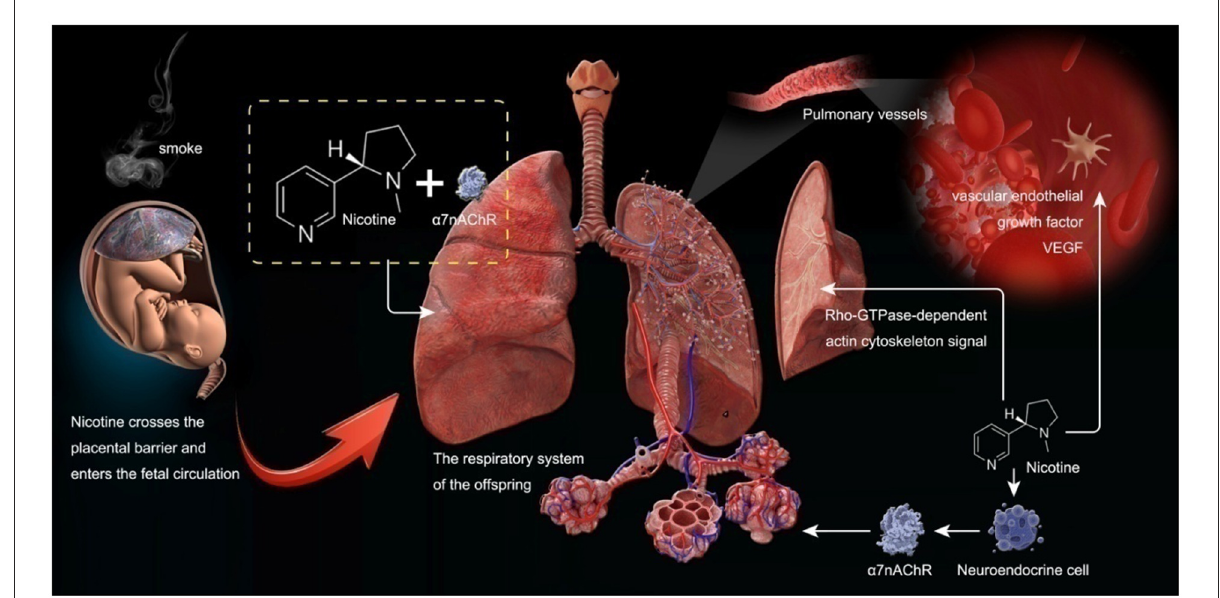
FIGURE5 The pathological mechanism of maternal smoking around birth on childhood